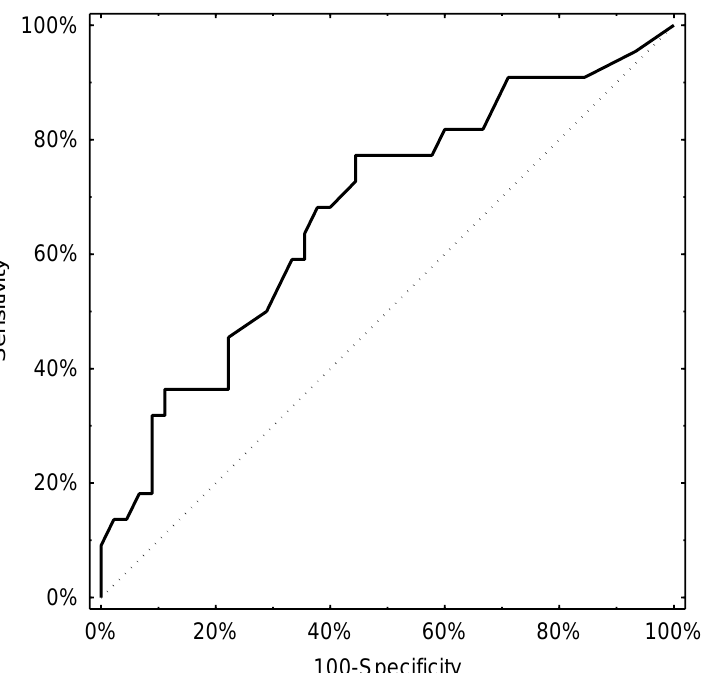
Figure 3. ROC curve derived from the number of acid reflux episodes and lesions in gastroscopy.